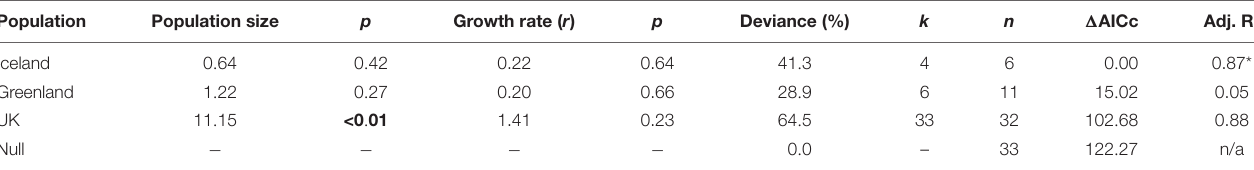
TABLE 2 | Model selection for generalized additive models (GAMs) of the relationship between trend estimates of vagrant LBBG occurrence in North America from CBC data and indices of annual breeding population size and growth rate ( r ) of the breeding population in the UK, Iceland, and Greenland. Population Population size p Growth rate ( r ) p Deviance (%) k n Iceland 0 . 64 0 . 42 Greenland 1 . 22 0 . 27